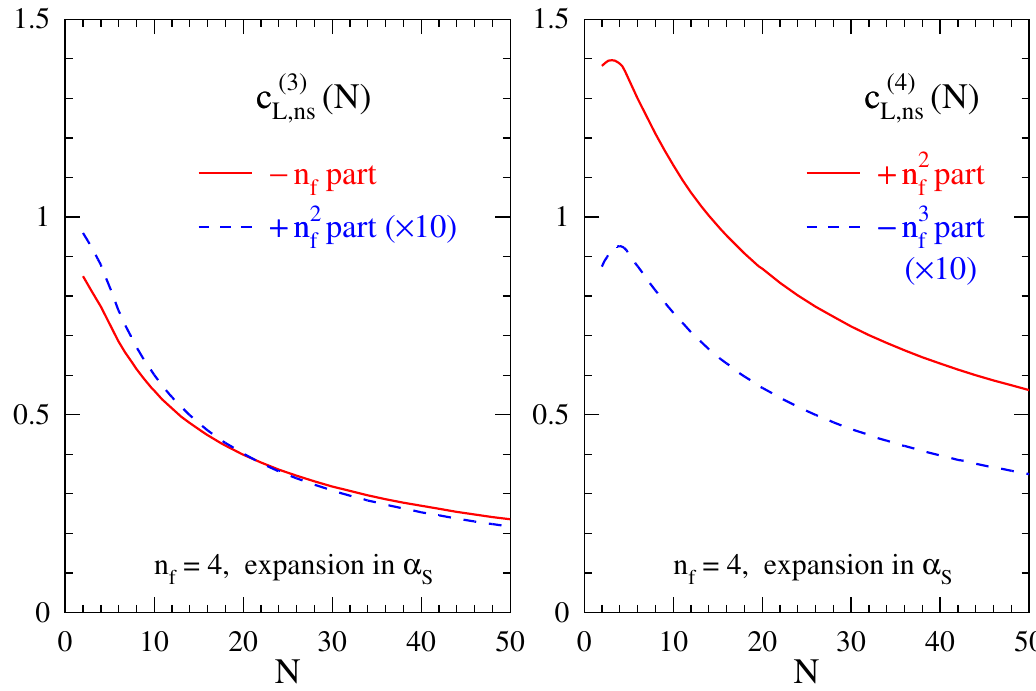
contributions to the three-loop f